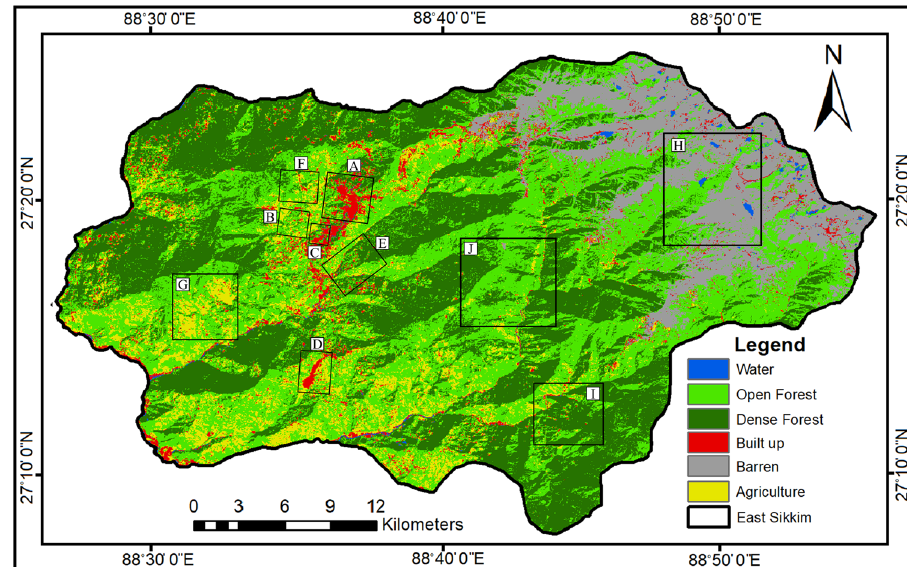
Fig. 5 Land-use/cover clas- sification of the study area with various sections A to